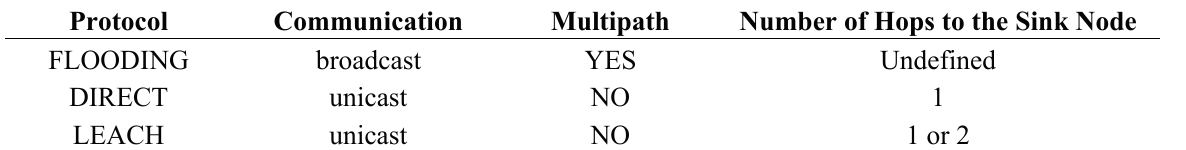
Table 1. Comparative elements of routing